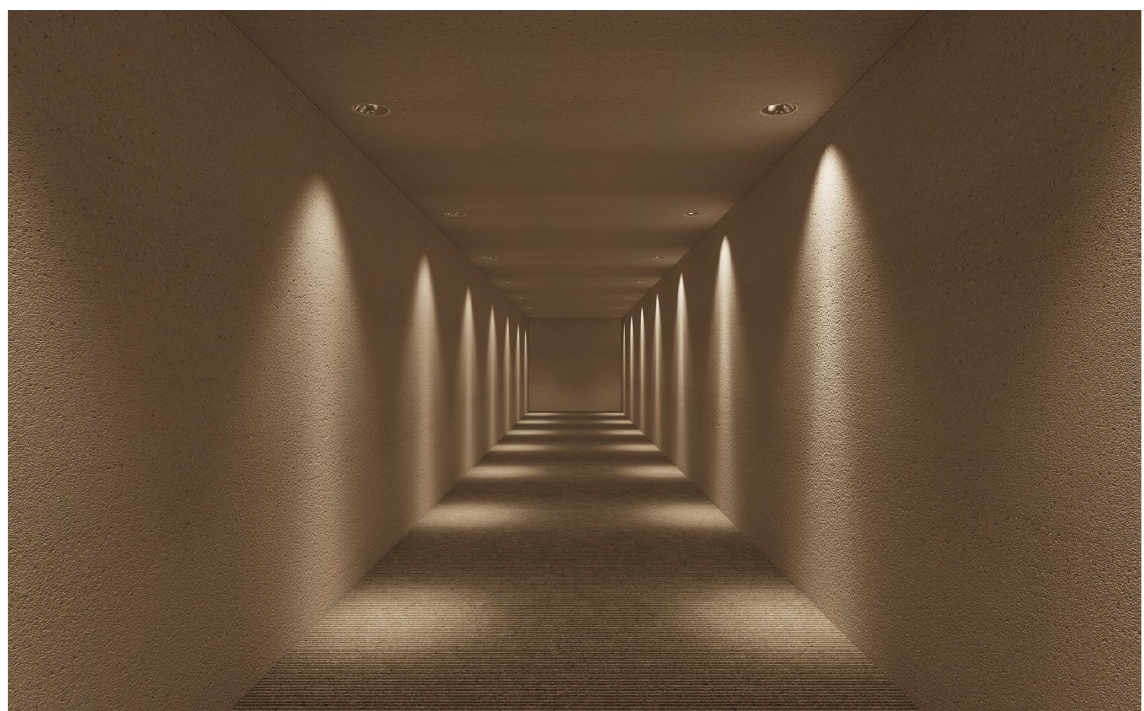
Figure 5. Computer simulation of corridor lighting for variant 2.